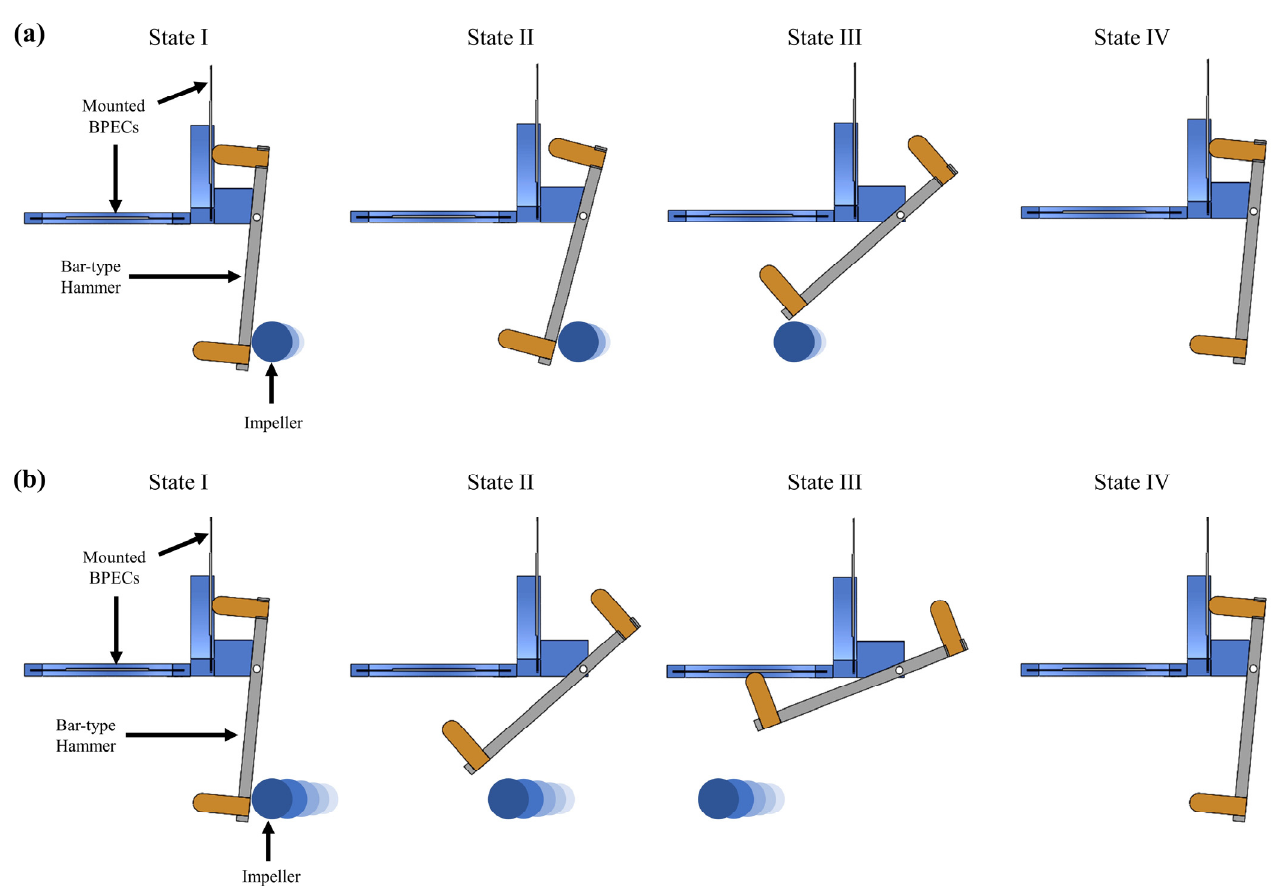
Figure 3. Schematic images of periodic movements for hammer-impact-driven power generator under conditions of ( a ) weak impact and ( b ) strong impact.